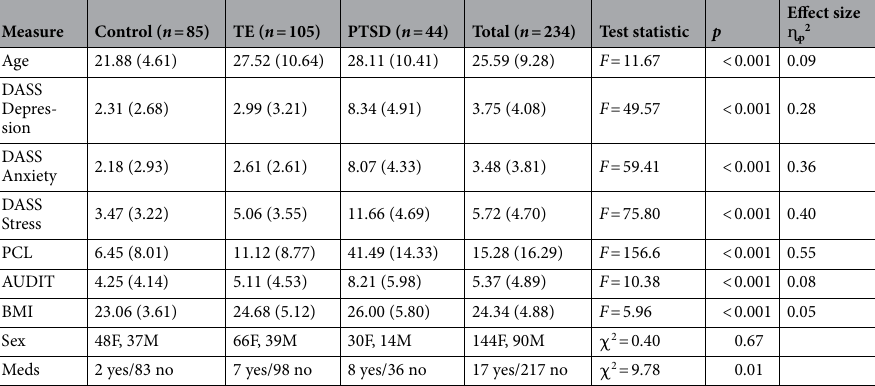
Table 1. Mean scores (standard deviations), significance and effect sizes of demographic and clinical measures for participants in the PTSD, TE and Control Groups. n number of participants in group, DASS depression anxiety and stress scale; PCL PTSD Checklist, AUDIT alcohol use disorder identification test, BMI Body Mass Index; refer to Supplementary Information for medication type/distribution.